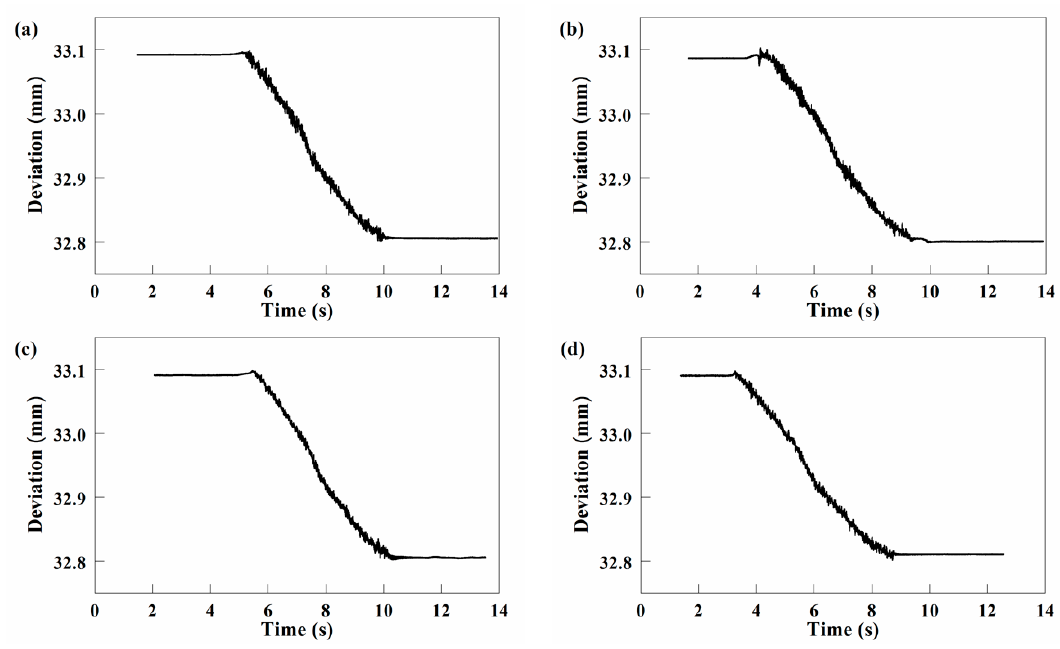
Figure 17. The measurements when PA is the measured surface ( a ) measurements 1 ( b ) measurements 2 ( c ) measurements 3 ( d ) measurements 4. 2 ( c ) measurements 3 ( d ) measurements 4.